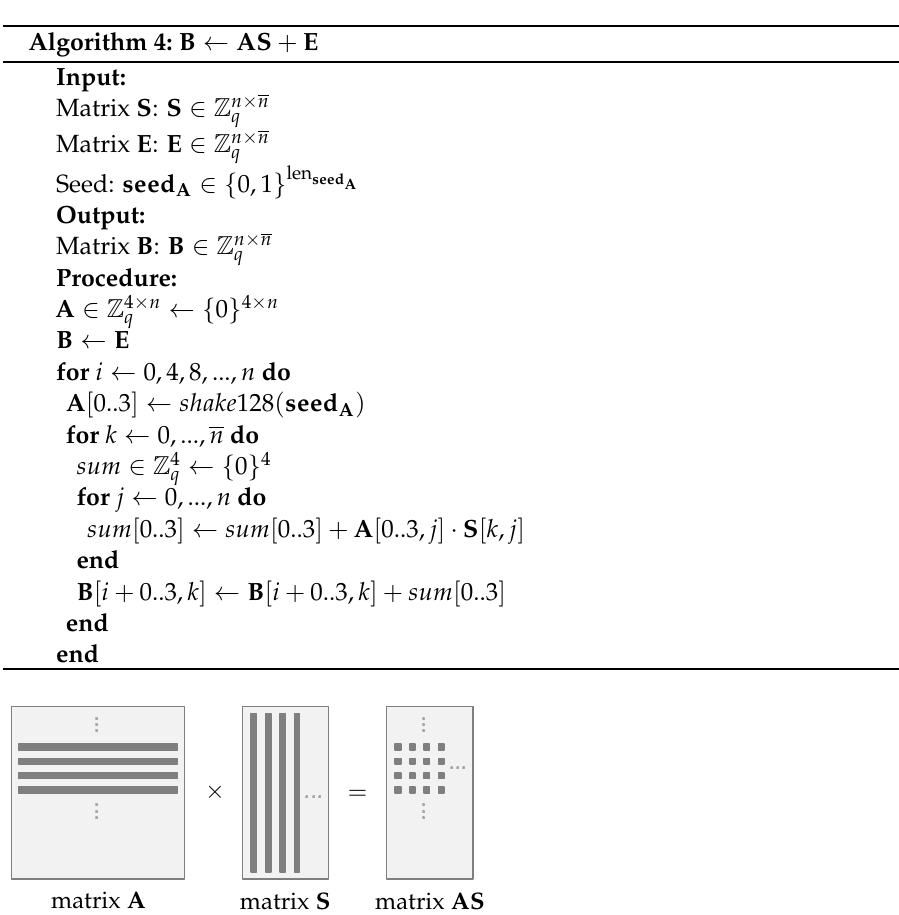
Figure 3. Operation AS A S . Multiplication of four rows of the matrix A by matrix S . ← ×